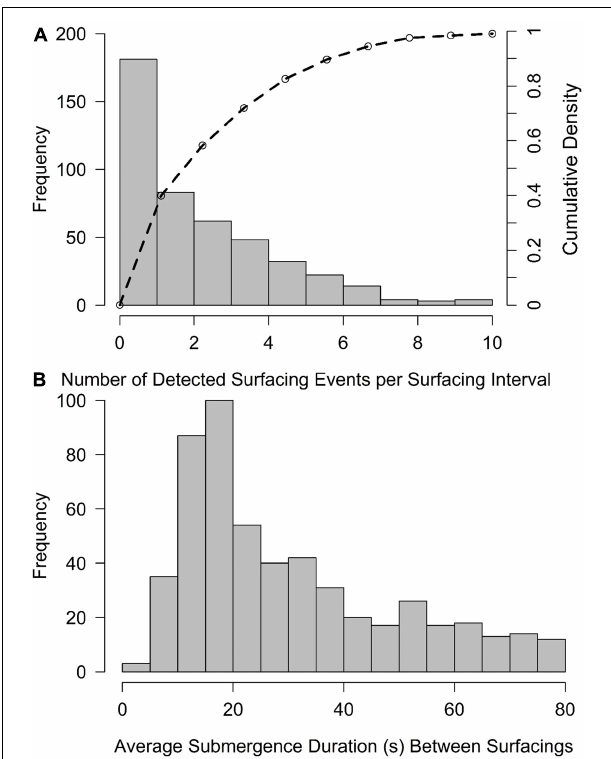
FIGURE 3 | Quantitative descriptions of whale surfacing behavior that help describe the ‘availability’ of humpback whales to be detected by ship personnel engaged in active whale avoidance in Alaska. (A) The average number of detected surfacing events per surfacing interval of humpback whales surfacing near large cruise ships, 2016–2017, with a curve representing the empirical cumulative density function. (B) Histogram of the average elapsed time between available surfacing events (submergence duration) during surfacing intervals of humpback whales surfacing near cruise ships, 2016–2017.